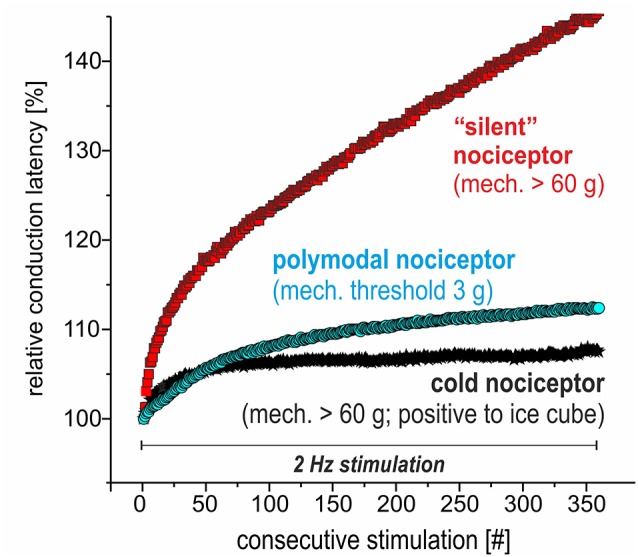
Specimen of extracellular in vivo recordings from single nociceptors in the saphenous nerve in pig visualizing the electrical stimulation protocol to assess activity-dependent slowing of conduction velocity (CV). Three different C-nociceptors [polymodal (light blue), mechano-insensitive (red) and cold nociceptors (dark blue)] are stimulated electrically inside their innervation territory in the leg and recorded in the proximal saphenous nerve. The electrical stimulation protocol consists of 360 pulses at 2 Hz for 3 min. Note that the activity-dependent slowing is extreme for mechano-insensitive “silent” nociceptors and moderate for polymodal nociceptors. Cold nociceptors are mechano-insensitive but are characterized by an even less pronounced activity-dependent slowing as compared to polymodal nociceptors.